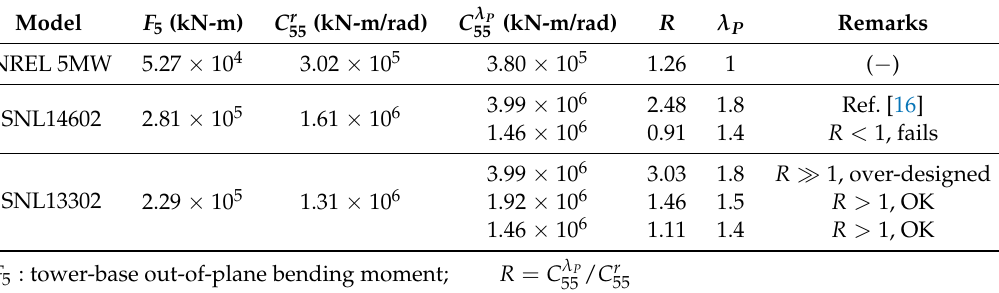
Table 7. Alternative models and evaluations against pitch motion